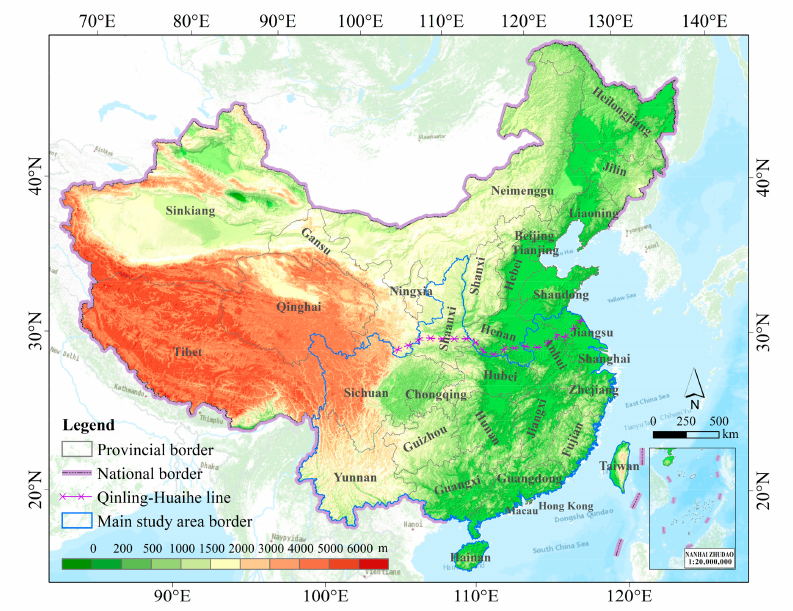
Figure 1. Location and elevation map of China, with the 16 provinces where bamboo forests are mainly distributed outlined by the blue